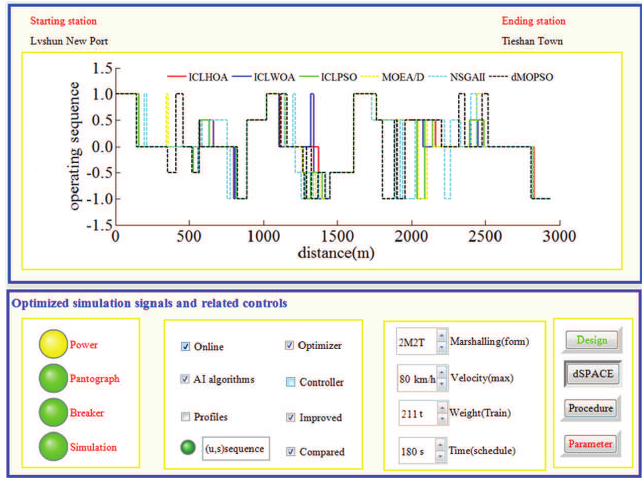
Figure 21. The velocity ideal trajectory profile obtained by different algorithms in isolating ‘control loop’ containing physical hardware devices (ICL)-HILS.